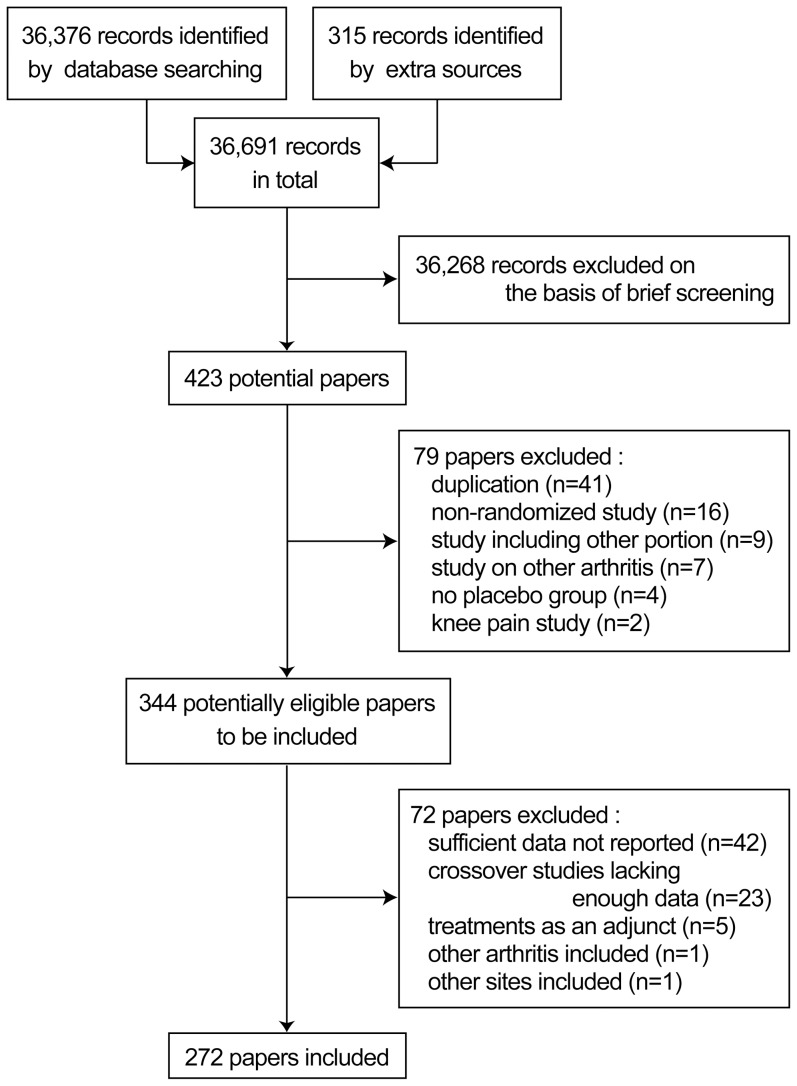
Study flow diagram.